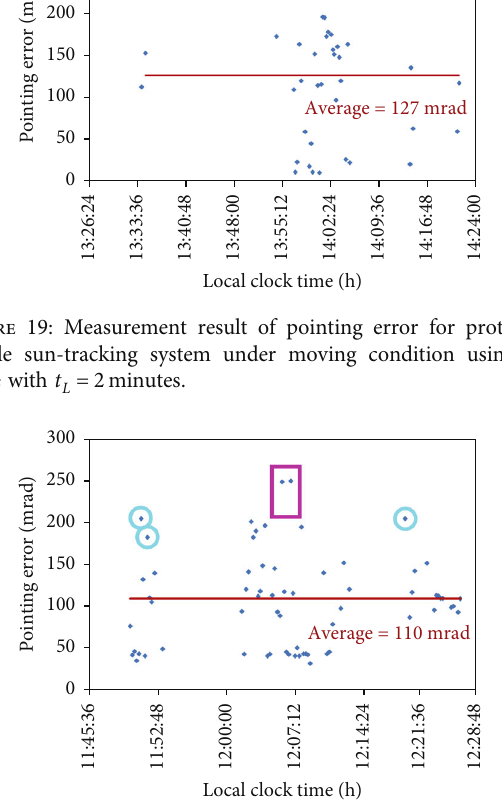
Figure 20: Measurement result of pointing error for prototype mobile sun-tracking system under moving condition using AA mode with triggering threshold = 0 : 1degree .